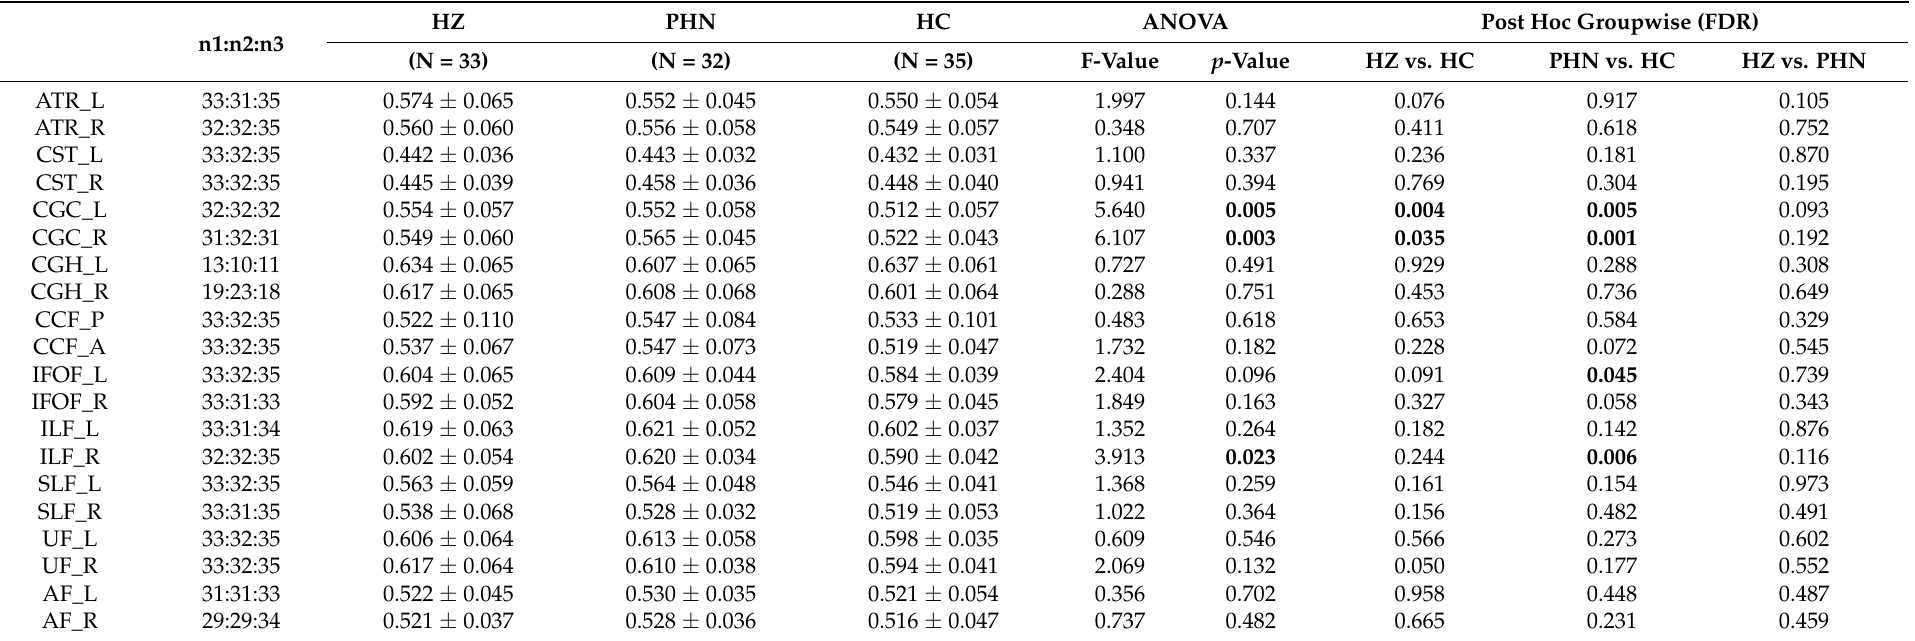
Table 4. Comparison of mean RD among the three